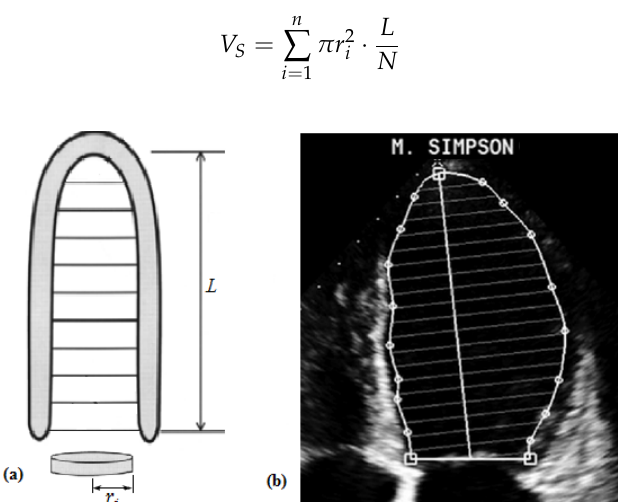
Figure 1. Schematic representation of Simpson’s model ( a ) and its aspect during the exam ( b ). Adaptations from Silva et al. [16] and Ramires et al. [17], respectively.